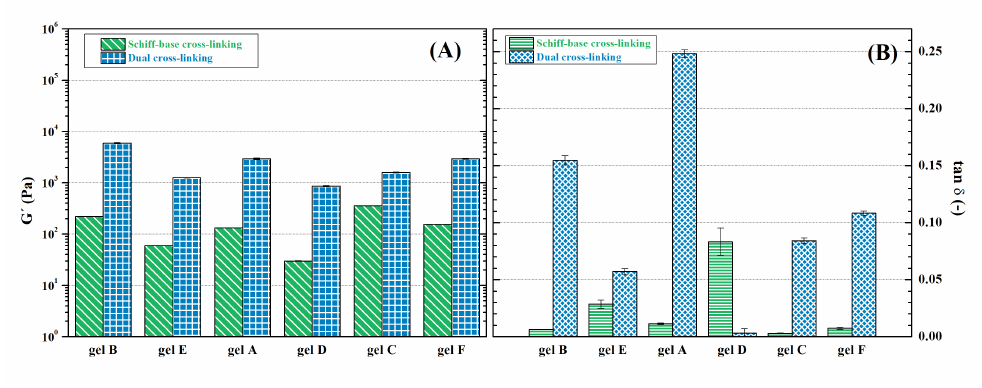
Figure 6. Comparison of ( A ) storage modulus and ( B ) damping factor of hydrogels cross-linked via Schiff bases and dually.